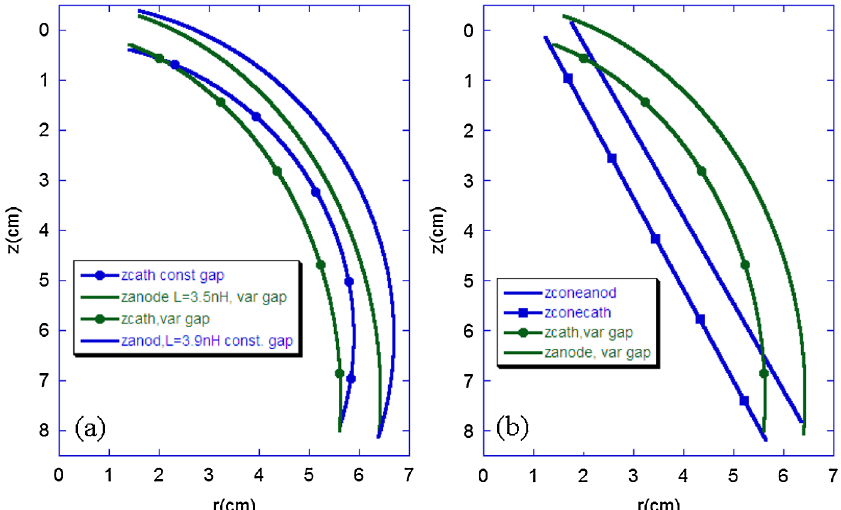
FIG. 4. (Color) These two figures, (a) and (b), show the electrode curves (cathodes marked with circles) for the optimal TL shown in Fig. (b). In (a) the comparison is between the optimal line of 0.8 cm constant gap and varying the gap as explained in the captions of Fig. 3 linearly from 0.6 to 0.8 cm, resulting in decreasing the vacuum inductance from 3.9 to 3.5 nH as it was described in the caption of Fig. 3. The optimal line of constant gap is in green. In (b) the comparison is between the optimal TL of Fig. 3(b) in green, and a straight-line midgap TL, in blue, with the same end points and end gaps. Vacuum inductances are [3.5, 3.8] nH,